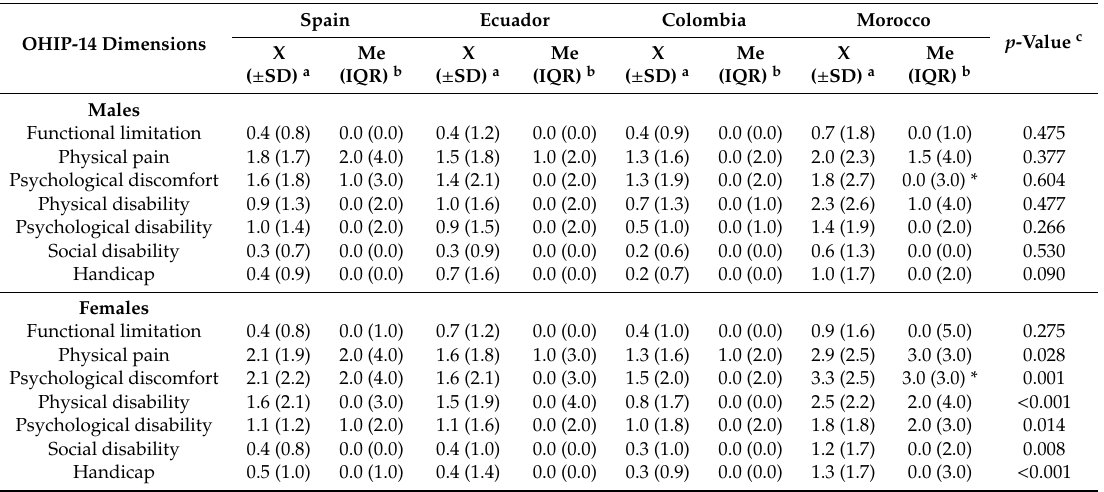
Table 4. Dimensions of the OHIP-14 according to country of origin in the PELFI cohort, Spain (n = 401). Spain Ecuador Colombia OHIP-14 Dimensions